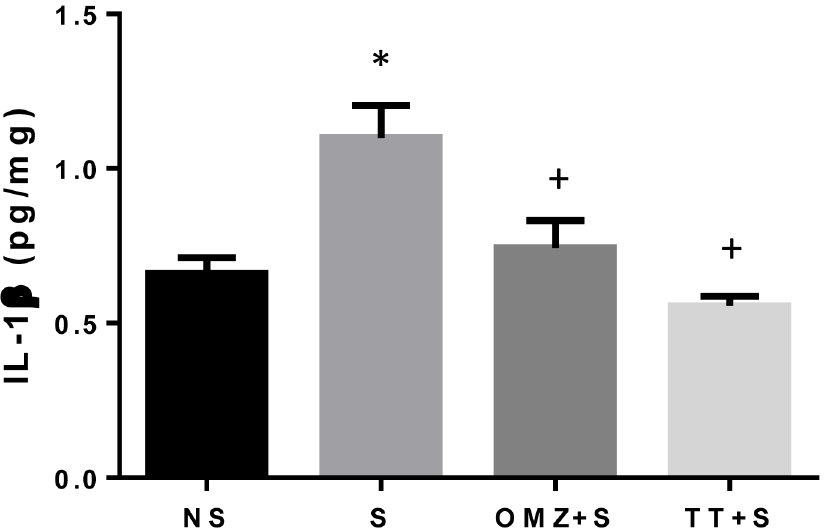
Fig 8. Effects of pre-treatment with tocotrienol (60 mg/kg BW) (TT) or omeprazole (20 mg/kg BW) (OMZ) on gastric Interleukin 1-beta (IL1- β ) protein concentration in rats exposed to water immersion restraint stress (n = 7). * vs non-stressed control (NS) (P < 0.05). + vs stressed control (S) (P <